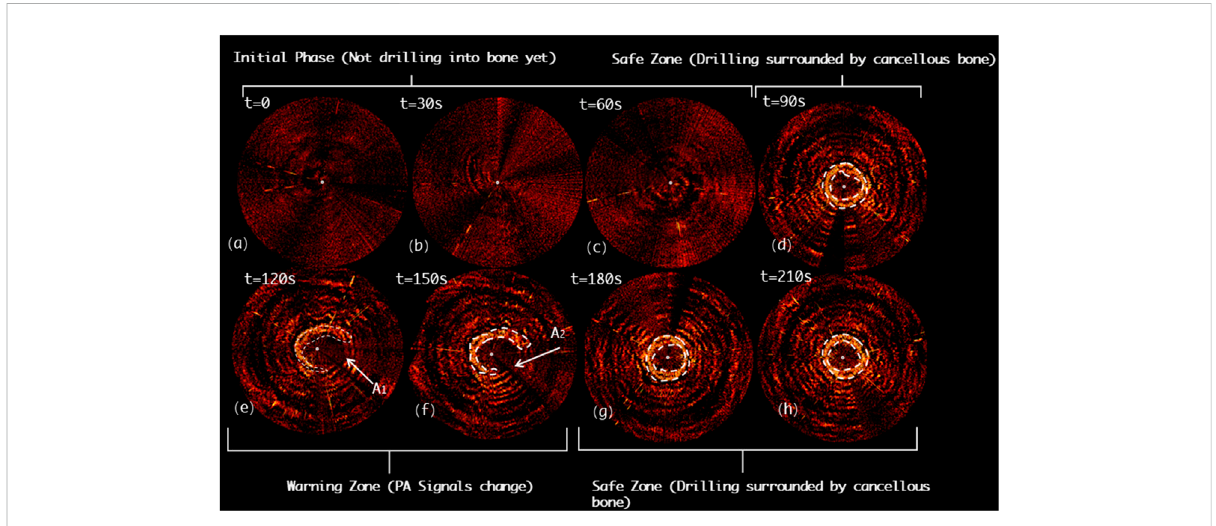
FIGURE 12 Acquired PAE images along the lateral misplacement path (LMP) for in situ bone tissue sensing. (A-C) Initial phase; (D) Safe zone; (E-F) Warning zone; (G-H) Safe zone.